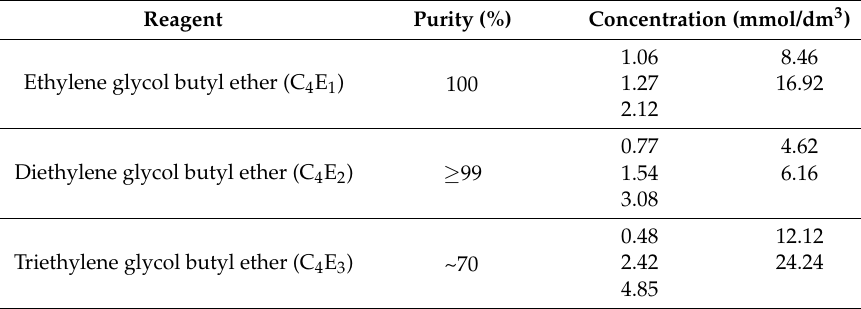
Table 1. List of the tested